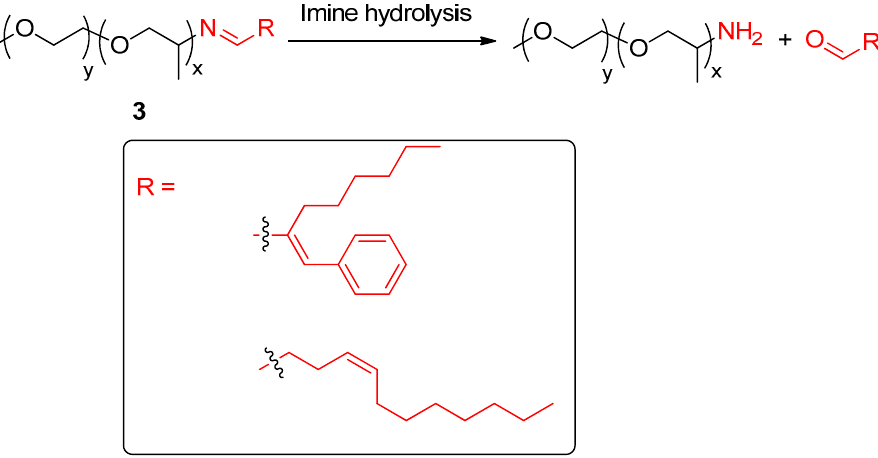
Figure 3. Release of aldehyde-based scents from profragrances 3 , highlighting the aldehyde scent precursor unit. The fragments of the scents are included in a box. The original results were reported by Giuseppone, Herrmann and coworkers [30].